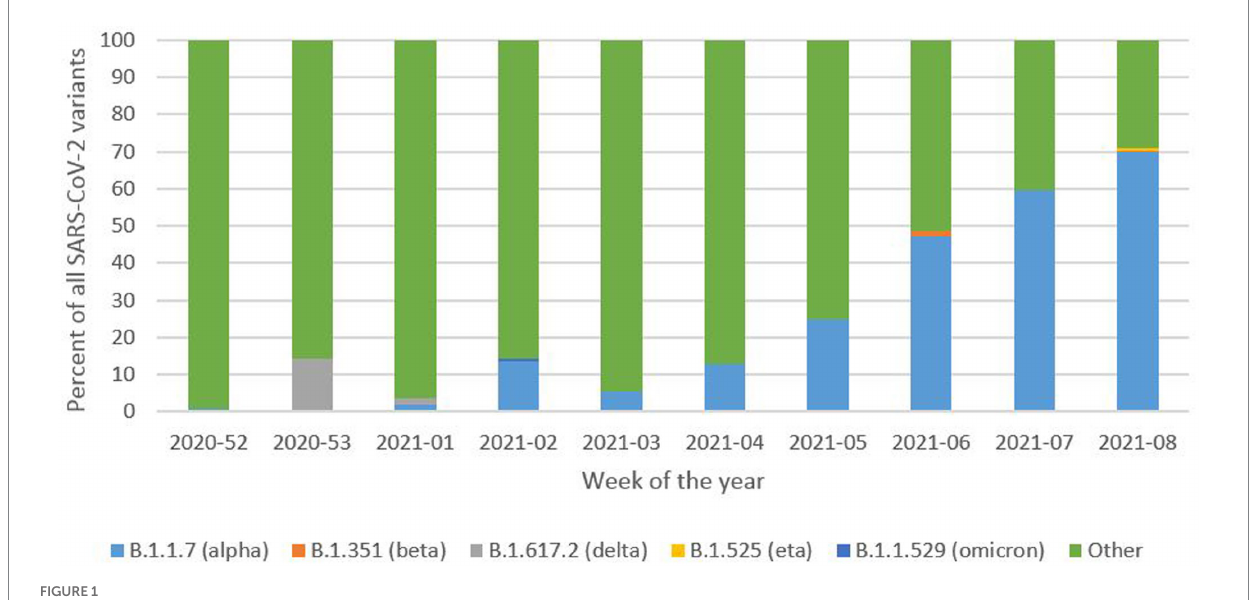
FIGURE 1 SARS-CoV-2 variant distribution in Poland reported during the time of survey response collection. Based on the data available from: